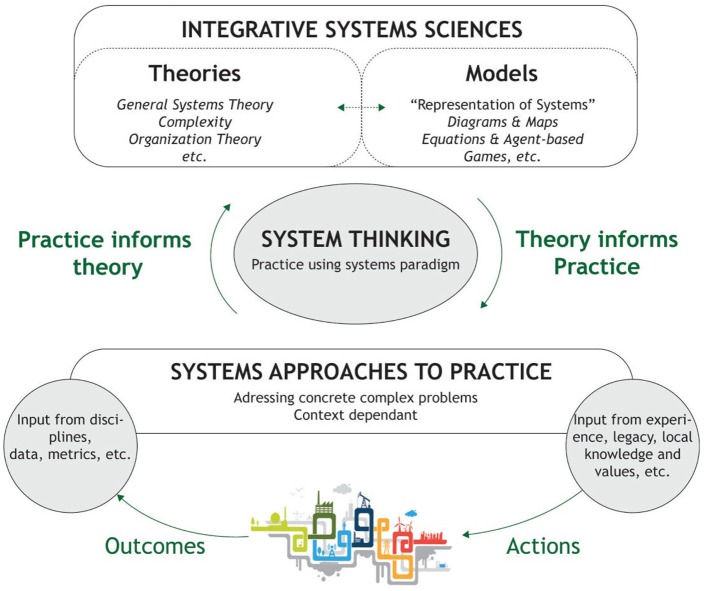
Systems thinking—Adapted from (65).